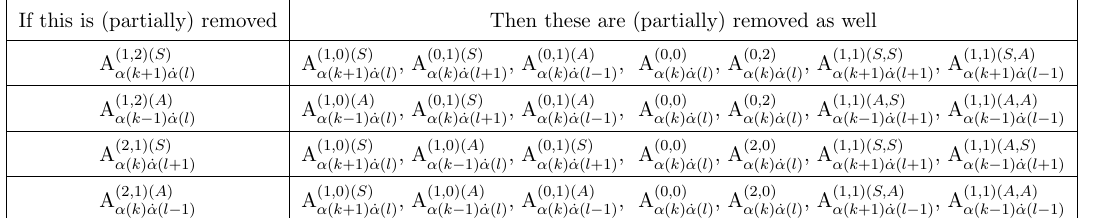
Table 4 . Conditional